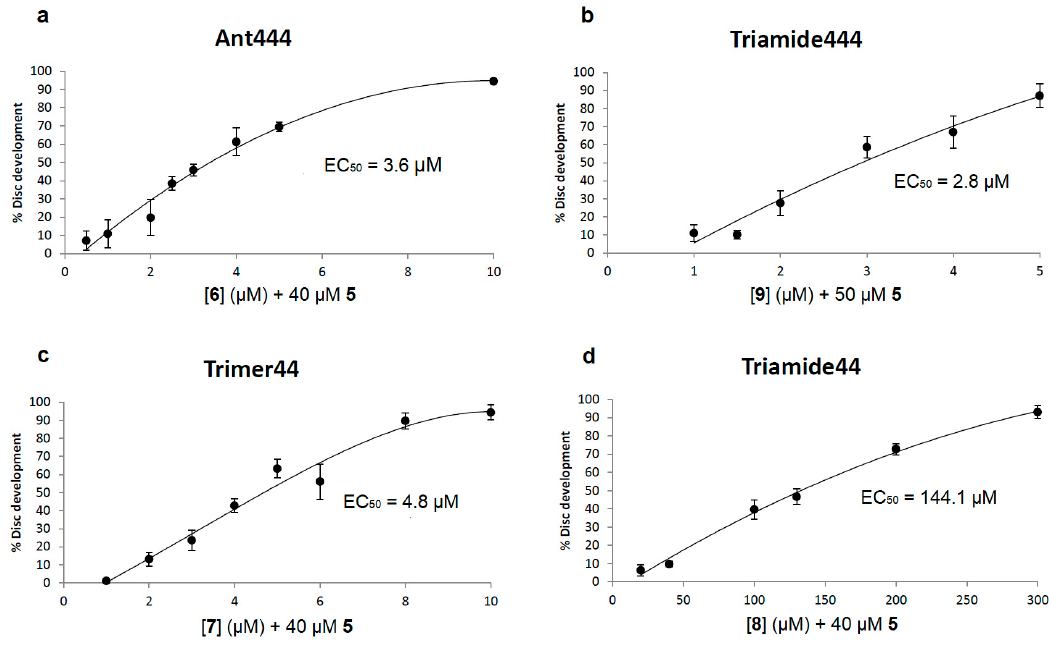
Figure 3. Compounds Ant444 ( 6 ) and Triamide444 ( 9 ) are effective PTIs. Candidate PTIs Ant444 ( 6 ) and Triamide444 ( 9 ) were tested in the presence of a toxic concentration of Ant44 ( 5 ) that by itself permitted the development of fewer than 10% of imaginal discs. The percentage of imaginal discs that developed was determined for each PTI concentration tested (see Section 2.3 for details). All assays were repeated at least in triplicate. Error bars reflect the standard error of the mean (SEM). ( a – d ) Respective dose-response curves of ( a ) Ant444 ( 6 ), ( b ) Triamide444 ( 9 ), ( c ) Trimer44 ( 7 ) and ( d ) Triamide44 ( 8 ) in blocking the inhibitory effect of Ant44 ( 5 ) on imaginal disc development. Note: the EC 50 value is the concentration of the compound needed to block 50% of the inhibitory effect of Ant44 ( 5 ) on imaginal disc development.